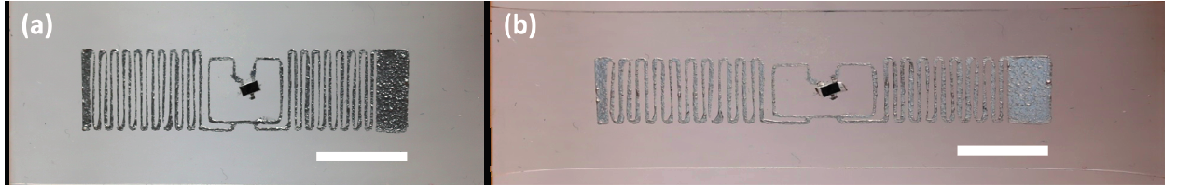
Figure 7. Stretchable RFID circuit with liquid alloy antenna and an integrated RFID chip: ( a ) Un-stretched; and ( b ) Stretched to 50% of the initial length. The scale bar is 10 mm.